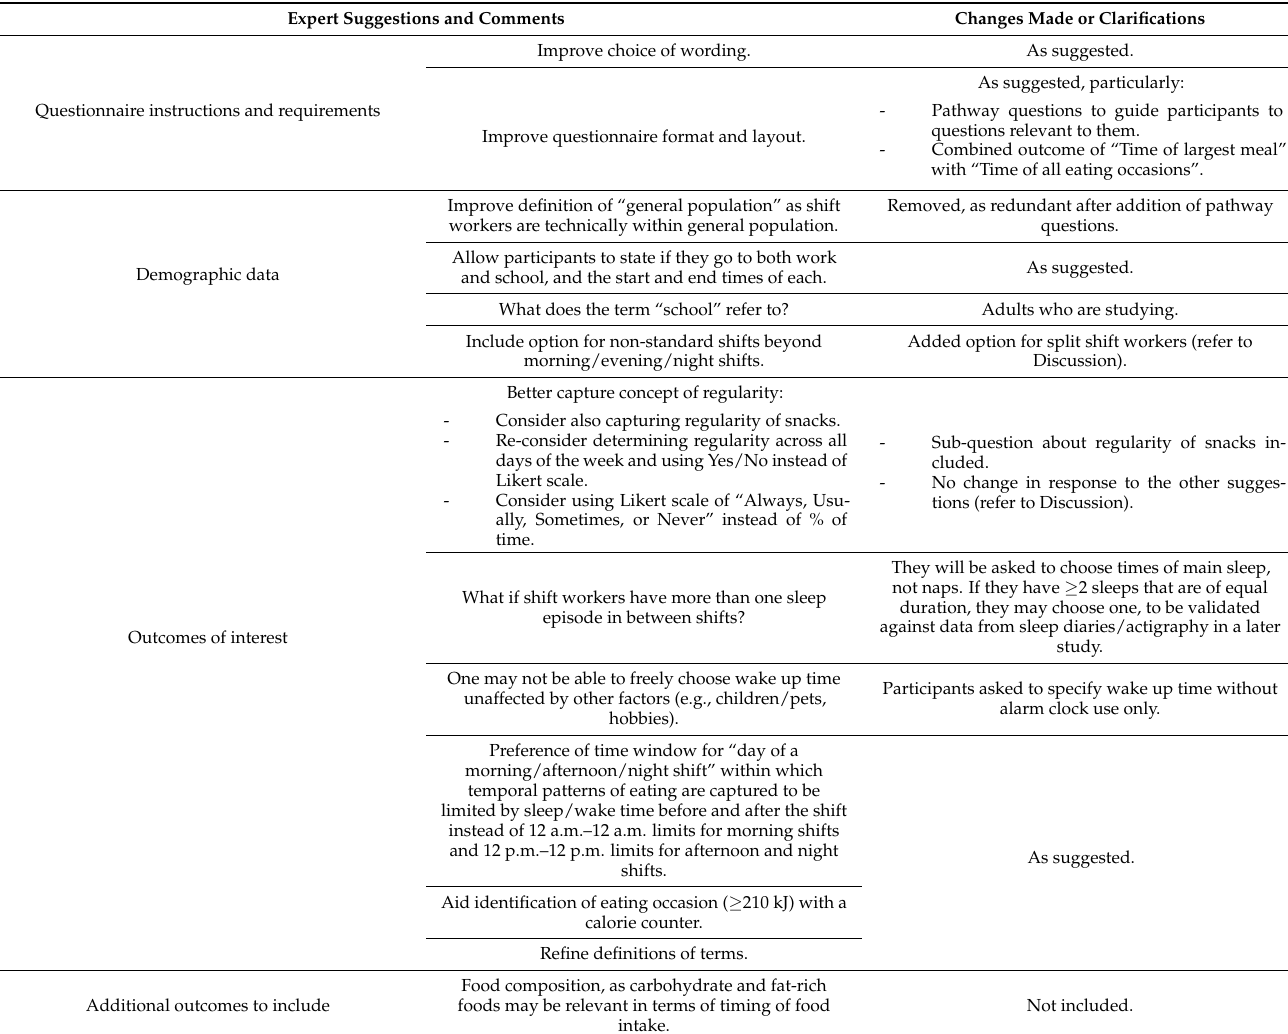
Table 4. Summary of comments provided by the expert panel and response by the research team in Round 2. Expert Suggestions and